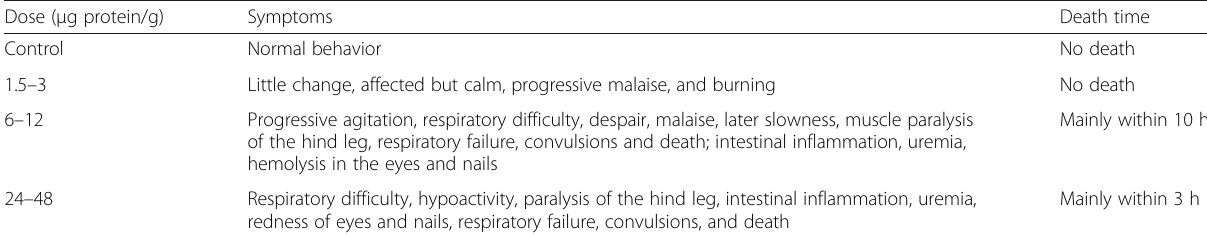
Table 4 Symptoms in mice induced by intravenous administration of the aqueous extract of M. alcicornis Dose ( μ g protein/g)